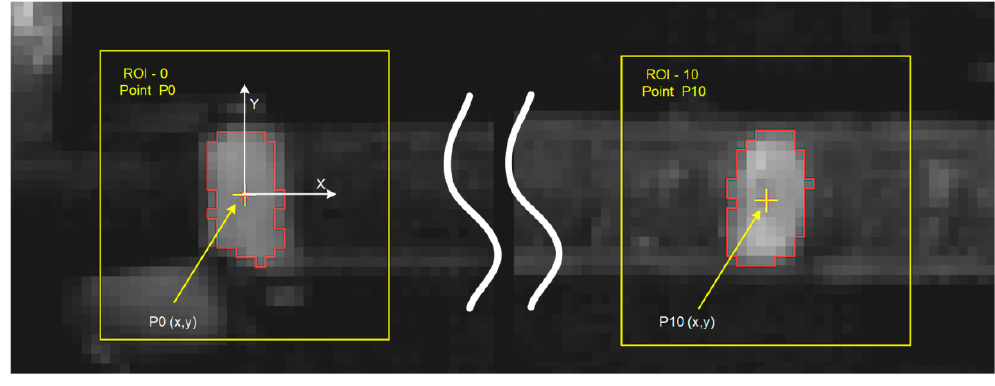
Figure 5. Beam with the assumed coordinate system and points P0 and